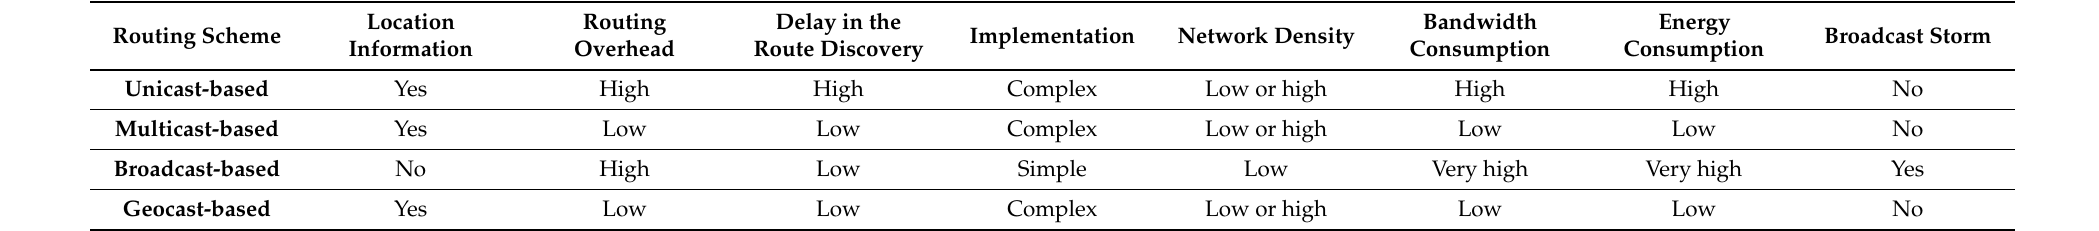
Table 7. Comparison of various data dissemination